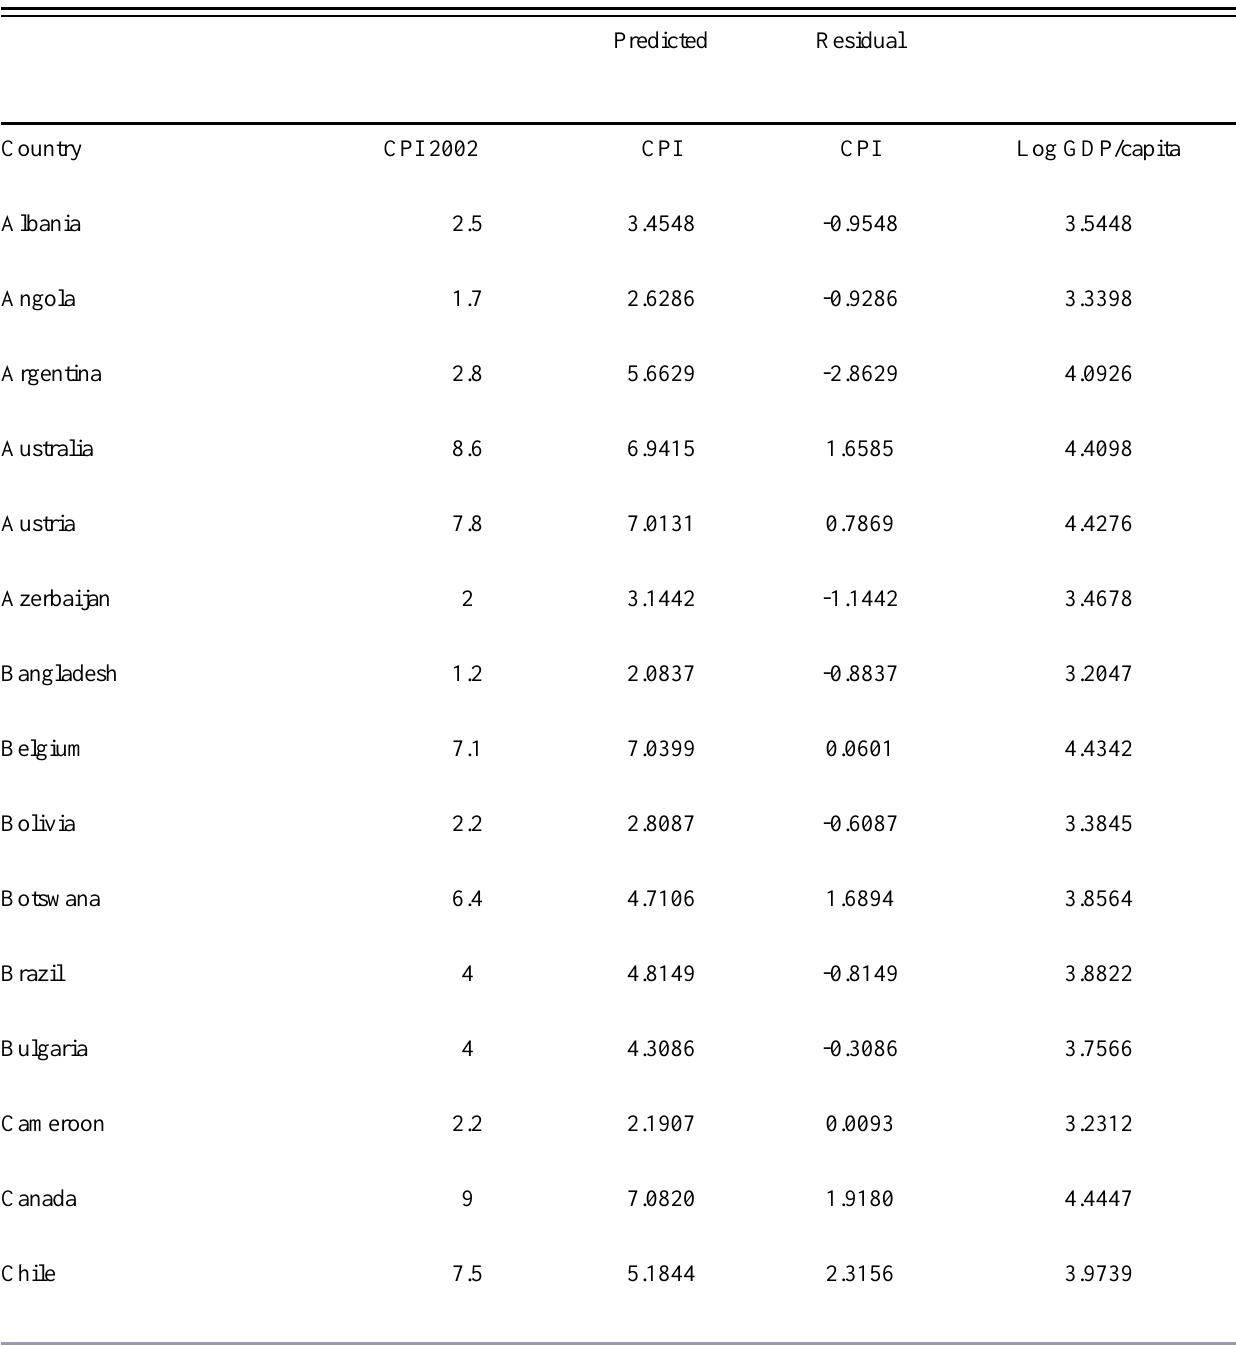
Table 5. Calculation of residual CPI based upon a regression of CPI 2002 and logarithm GDP per capita for 2000. CPI: scale of 0 (most corrupt) to 10 (least